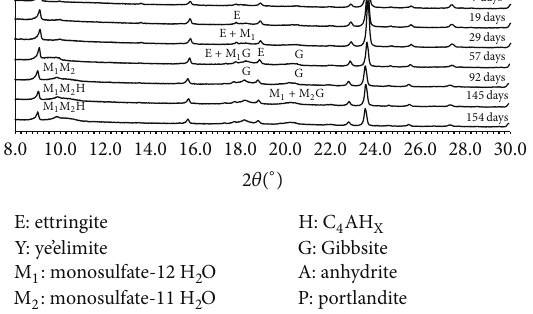
Figure 3: XRD patterns of hydrated ye’elimite clinker exposed to environment of saturated water vapour, aged 1–159 days of hydration.